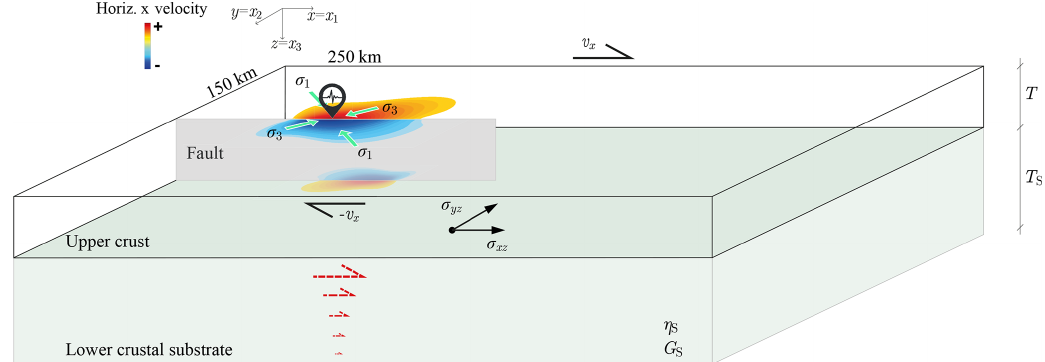
Figure 2. 2.5-D model setup of the dextral in-plane strike-slip simulation: 2-D box of size 250km × 150km with 501 × 301 nodes in the x and y direction, respectively (grid resolution of 500m). Each cell contains 16 markers, resulting in 2400000 global mobile markers. Bold black shear arrows indicate the direction of Dirichlet v x -velocity boundary conditions applied in the opposite direction: v x = ± 2 × 10 − 9 ms − 1 . At the left and right boundaries, Neumann boundary conditions for v x are prescribed. Velocity v y is set to zero at all boundaries. The 120km long fault (in gray) has a lower state θ compared to the host rock. The third ( z ) dimension is approximated by a depth averaging of upper crustal stresses due to a relaxed lower crustal substrate (Sect. 2.1). A symbolic earthquake rupture occurring on the fault is shown by horizontal x -velocity contours in red and blue at the location of a seismic wave sign. Light green arrows with white contours mark the direction of the principal compressional stresses; the maximum one, σ 1 , is initially oriented at 45 ◦ . The counteracting effect of the rupture on stresses in the relaxed substrate is shown by the red dashed arrows. The directionality of shear tractions σ xz and σ yz on the lower surface of the upper crust is represented by black arrows with triangular heads. The quantities η S and G S and the dimensions T and T S are listed in Table 1.